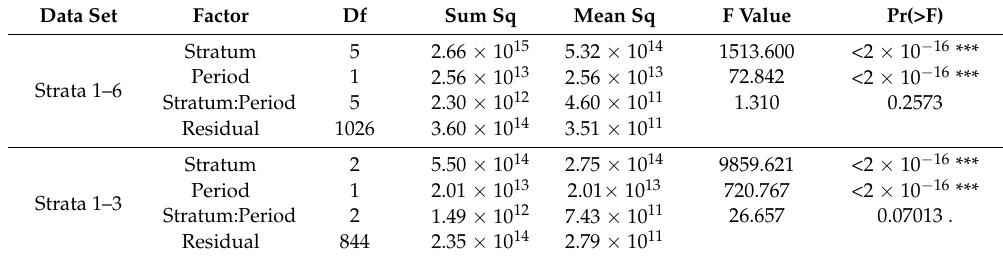
Table A8. Two-way ANOVA with interaction. Variable: Amount Paid for water and sewerage services without the programme